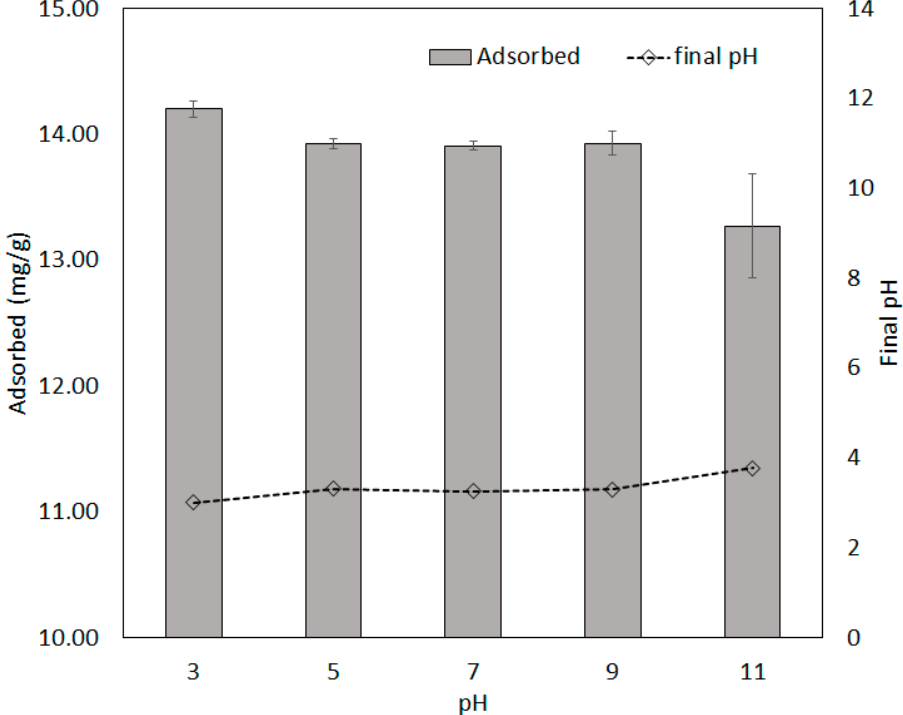
Figure 7. Adsorbed amounts of Sb(V) and final pH as a function of initial solution pH.